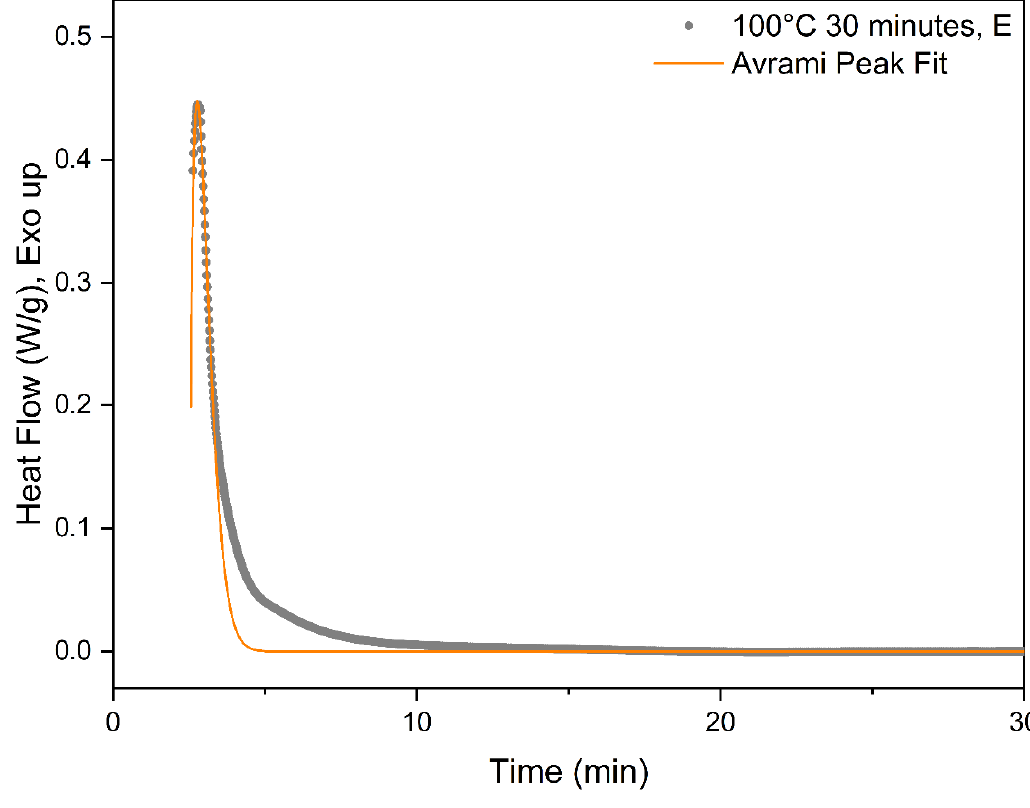
Figure 4. Avrami curve fitting for 100 °C DSC isotherm.